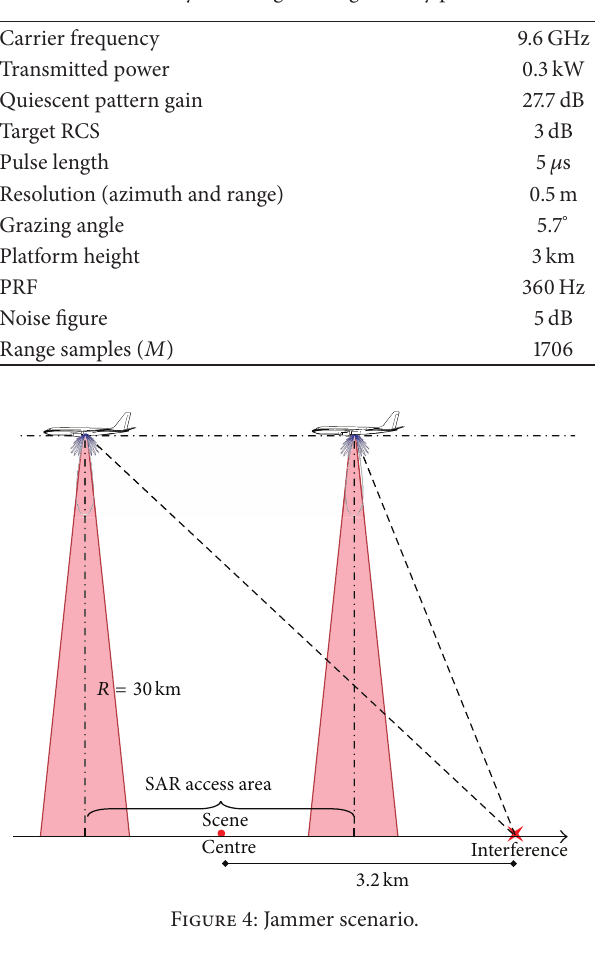
Table 1: Main system, target, and geometry parameters.